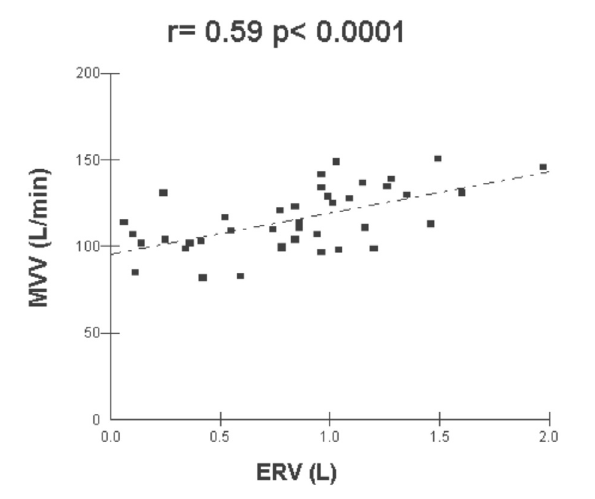
Figure 4 - Correlation between the expiratory reserve volume (ERV) and the maximum voluntary ventilation (MVV)